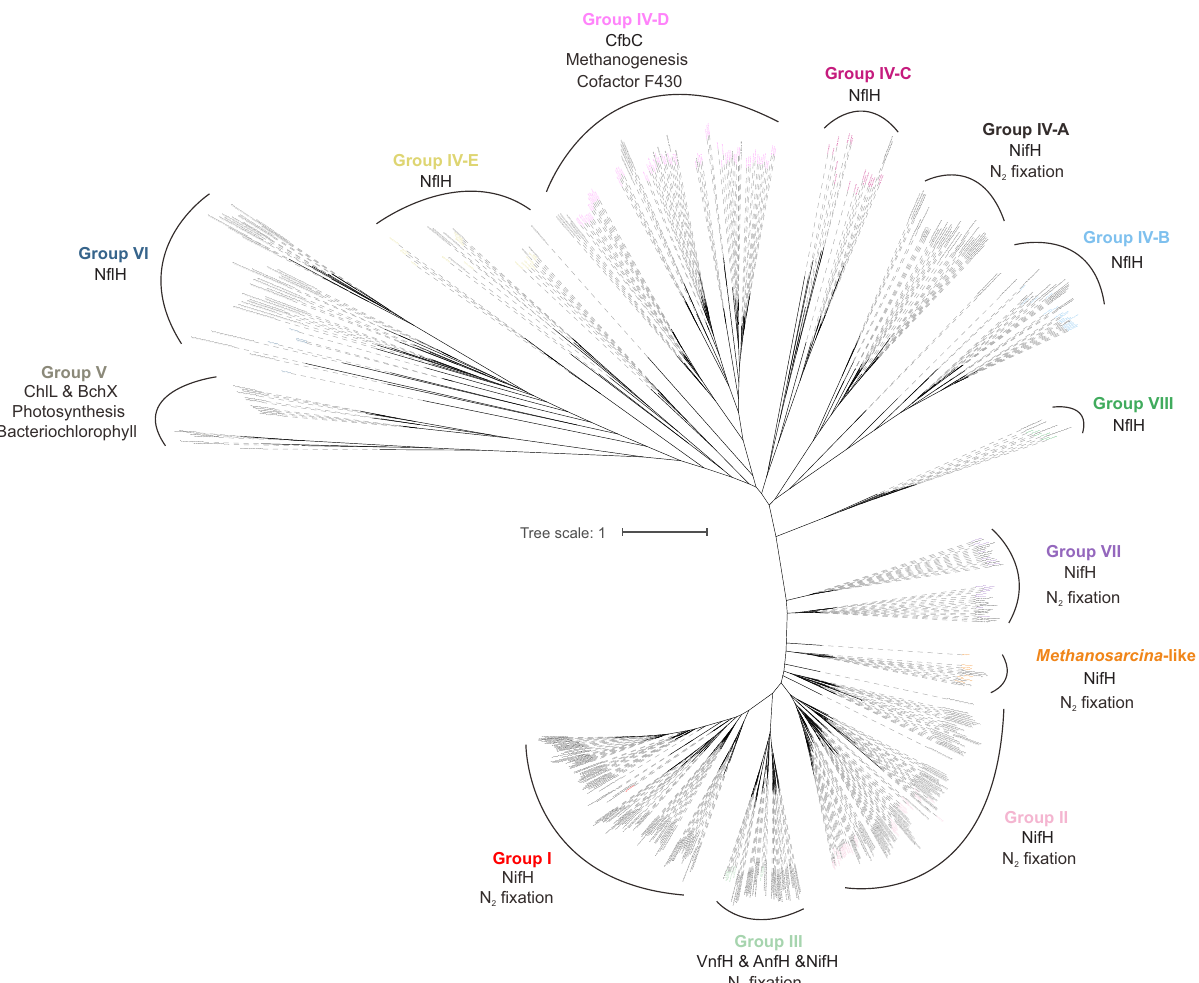
Fig. 2 | Maximum-likelihood phylogenetic tree of non-redundant nitrogenase subunit NifH identi fi ed from cold seep metagenomic assemblies. Homologues of nifH wereclassi fi ed intocanonicalgroupsItoIII,nitrogen fi xation-like groupsIV